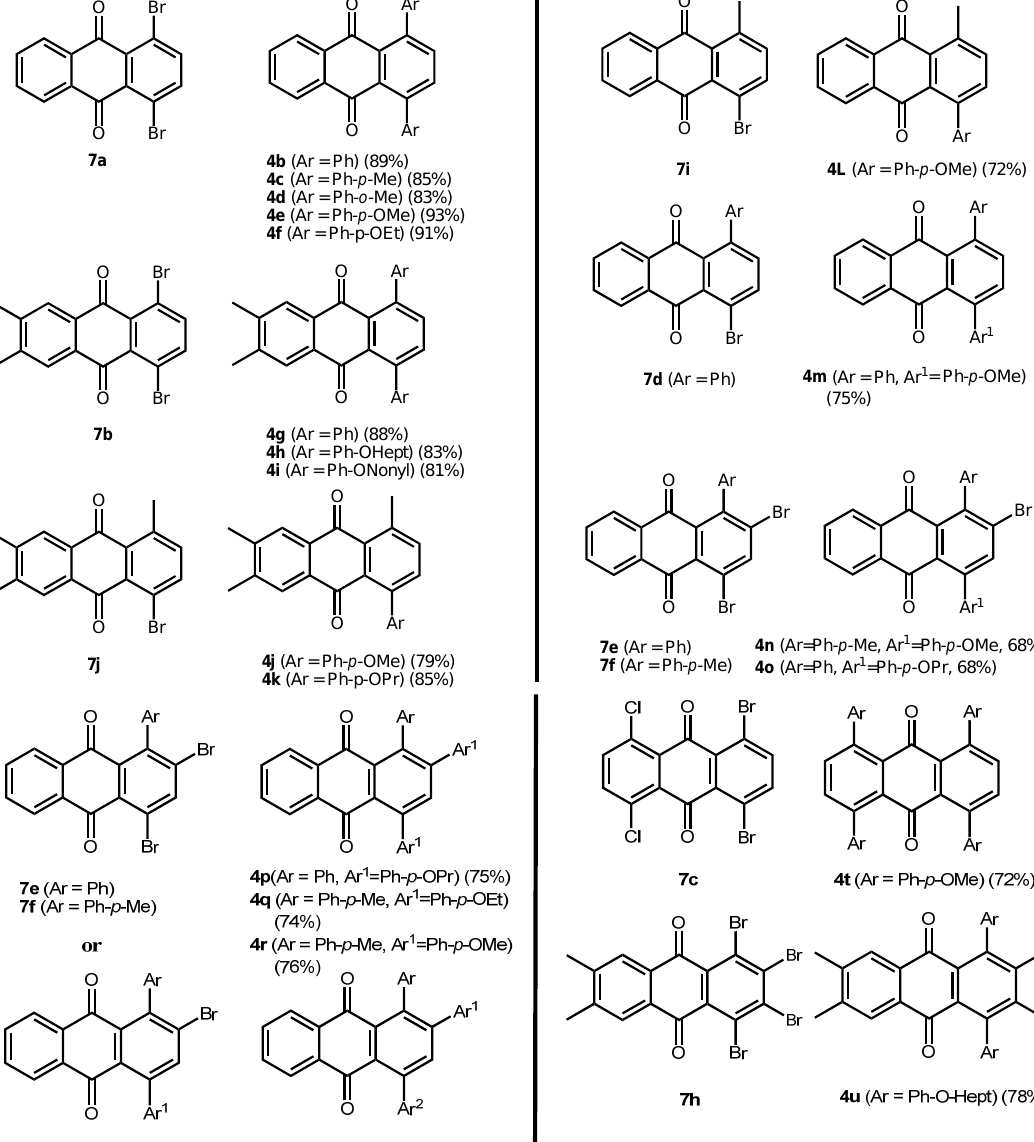
Table 2. Arylated anthraquinones by Suzuki-Miyaura coupling of dibromoanthraquinones.